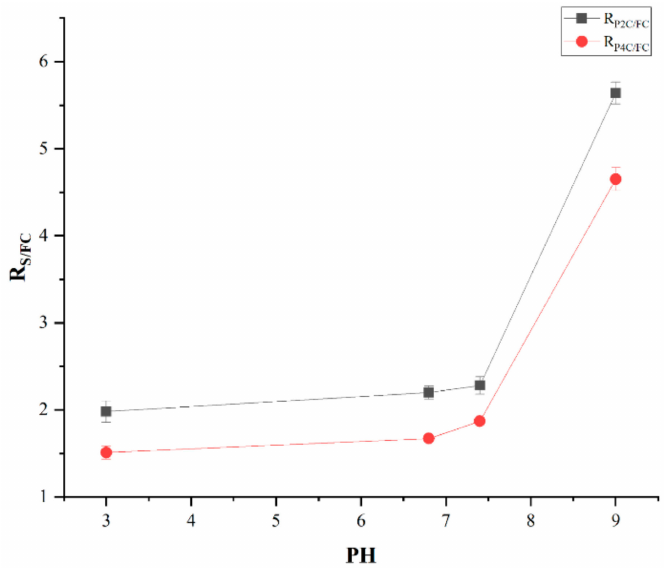
Figure 8. R S/FC variation in function of pH values of the buffer